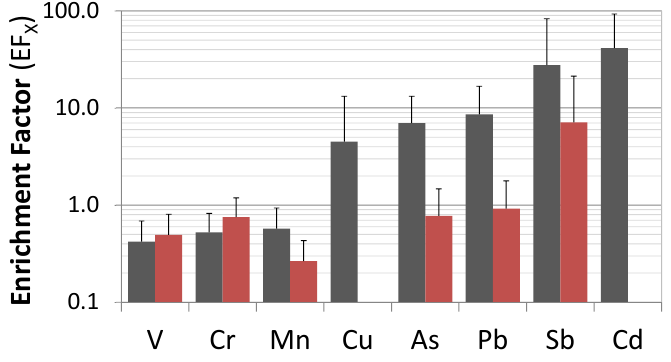
Figure 6. Enrichment factors using Sr as a reference element and the soil compositions presented by Mason and Moore [35] (grey bars) and Glorennec et al. [7] (red